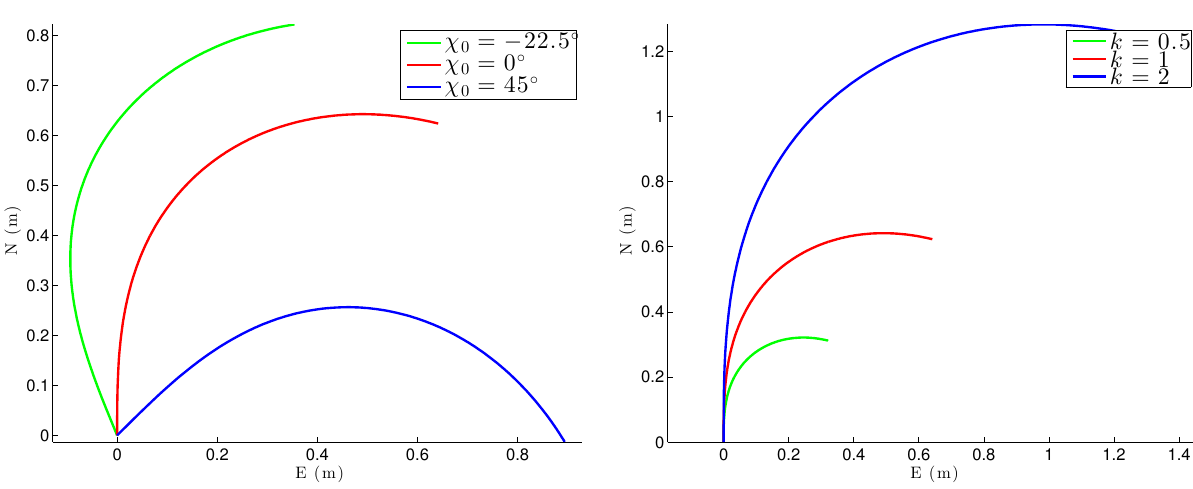
Figure 9: Fermat’s spiral segment with fixed scaling Figure 10: Fermat’s spiral with fixed initial tangent an- (k=1) and different initial tangent angles gle ( χ 0 = 0) and different scaling